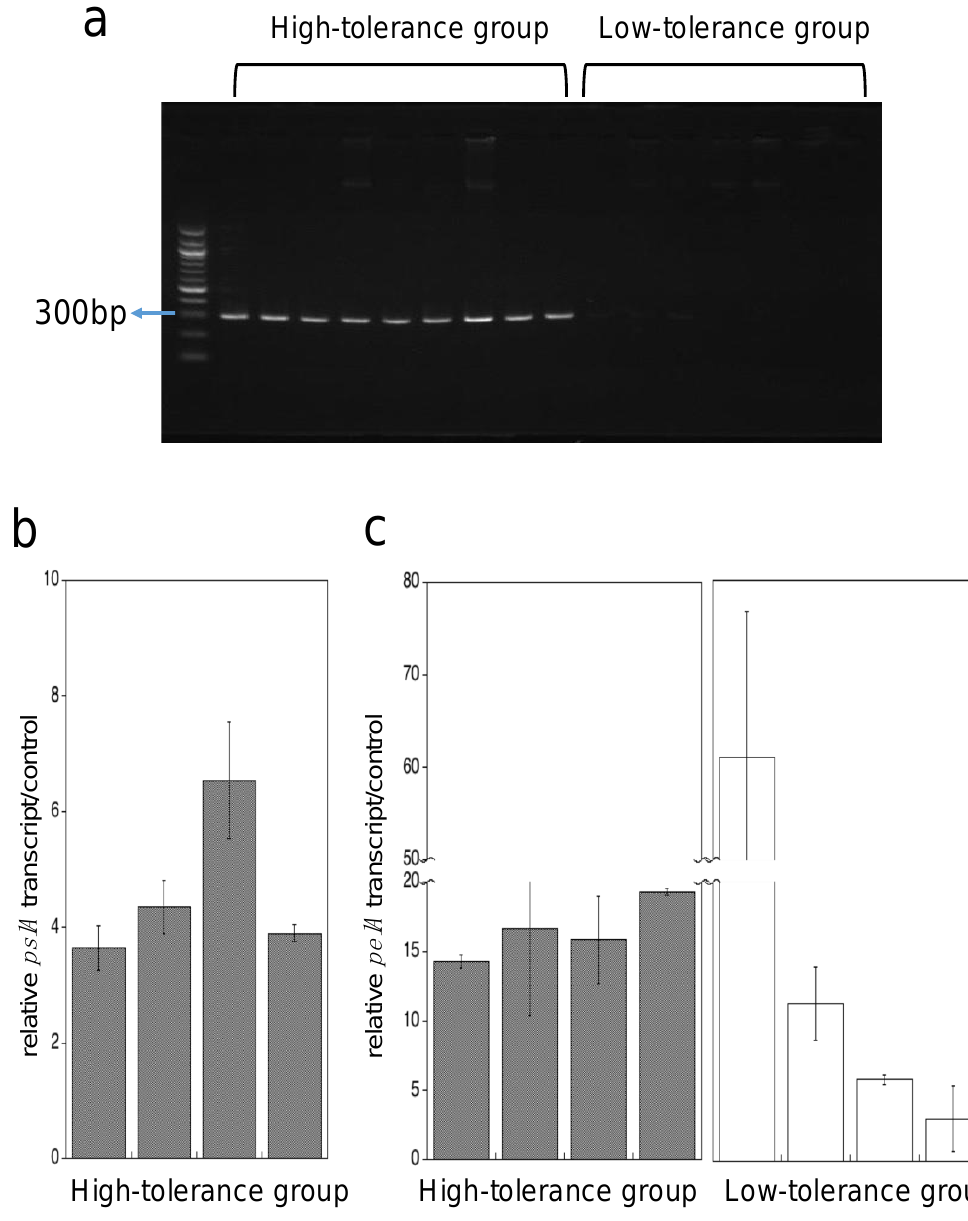
Figure 6. pslA gene detection and transcription of pslA and pelA genes in adherent cells. Agarose gel electrophoresis of pslA amplicon (309bp) ( a ). PCR products were detected using 1.7% agarose gel stained with GelRed ™ . pslA gene expression of adherent cells in the high-tolerance group ( b ), and pelA gene expression of adherent cells in the high- and low-tolerance group ( c ) are shown. The black bars represent the high-tolerance group ( n = 4), and the white bars represent the low-tolerance group ( n = 4). Each experiment was performed in triplicate. The data are presented as the mean ± SD for three